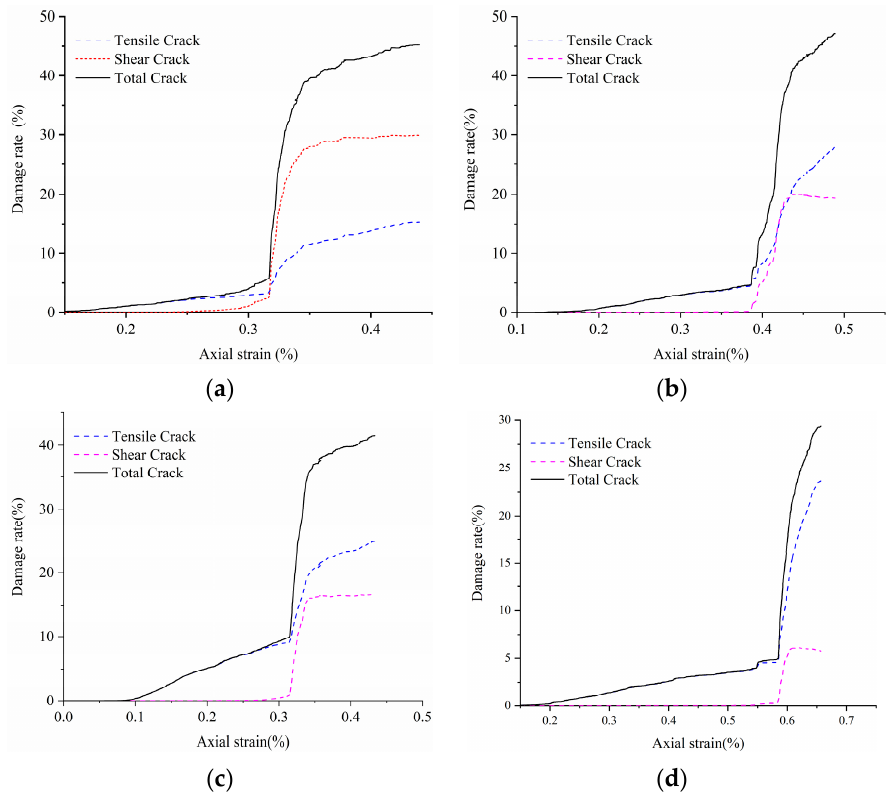
Figure 8. Damage rate of various rock specimens. ( a ) LdB granite, ( b ) Augig granite, ( c ) TS, and ( d ) coal.